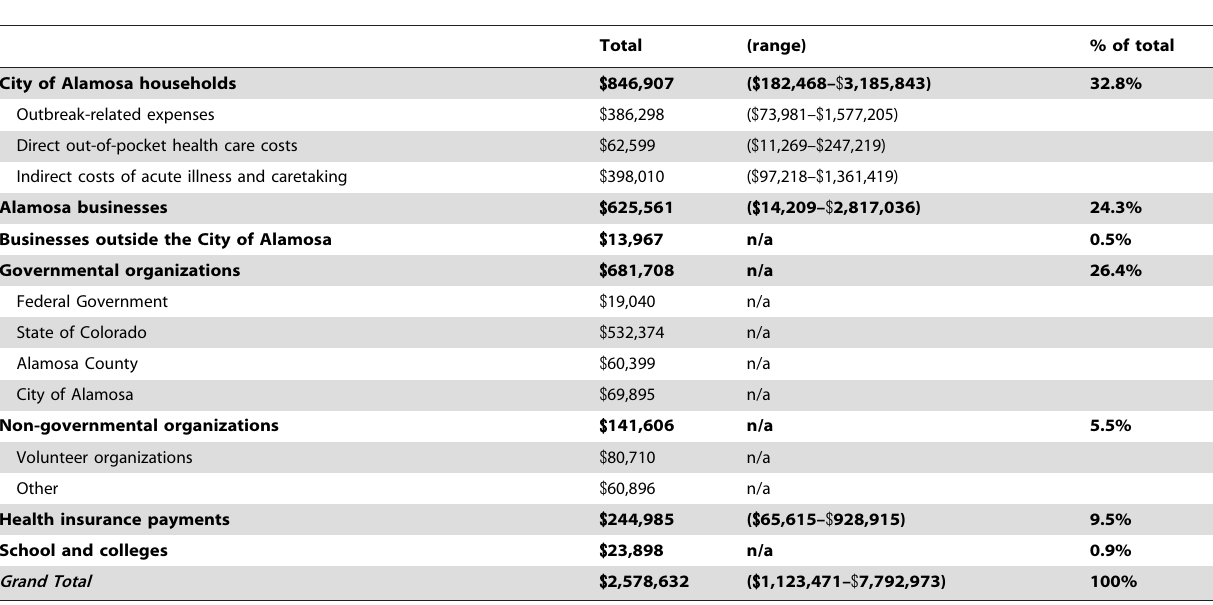
Table 9. Total costs associated with an outbreak of salmonellosis, Alamosa, Colorado 2008.